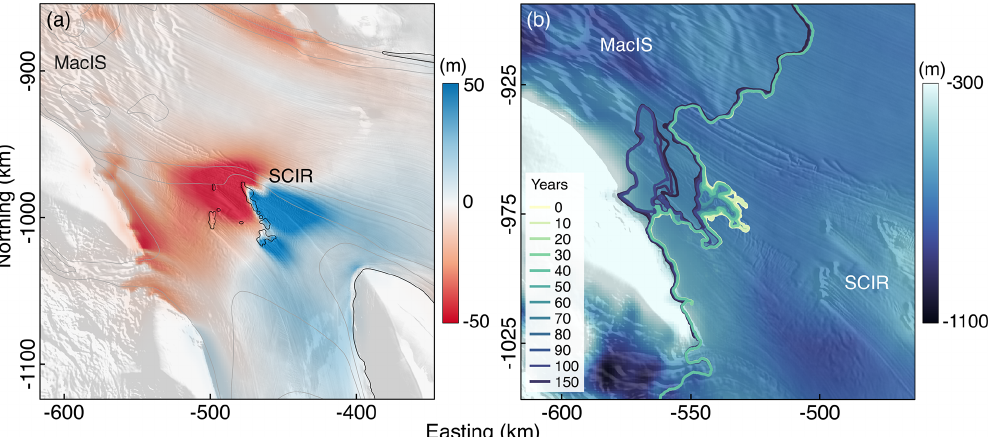
Figure 11. (a) The total change in ice thickness 150 years after removal of the SCIR. Red indicates thinner ice, and blue indicates thicker ice without the ice rumples. (b) Retreat of a section of the simulated MacIS grounding line ( B inv case) following removal of the SCIR plotted on the subglacial bed elevation (Fretwell et al.,